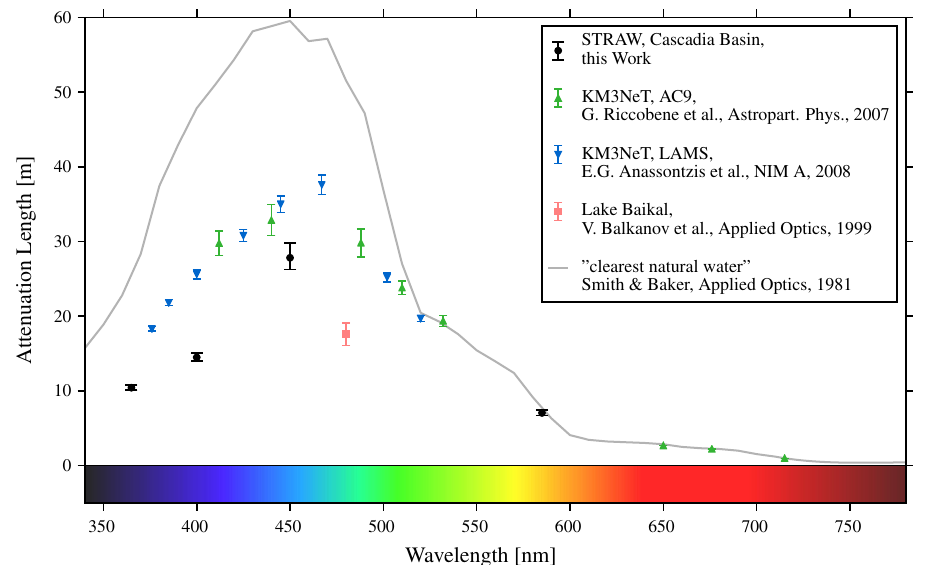
Marine Spectrophotometer (LAMS, blue data points) using LEDs and photodiodes. From the data measured with the AC9 the values obtained at 3000 m.b.s.l. and the site denoted PC1 have been plotted for refer- ence. The LAMS values that have all been measured close to the Capo Passero site of KM3NeT have simply been averaged for this plot, while the standard deviation between the measurements is reflected in the